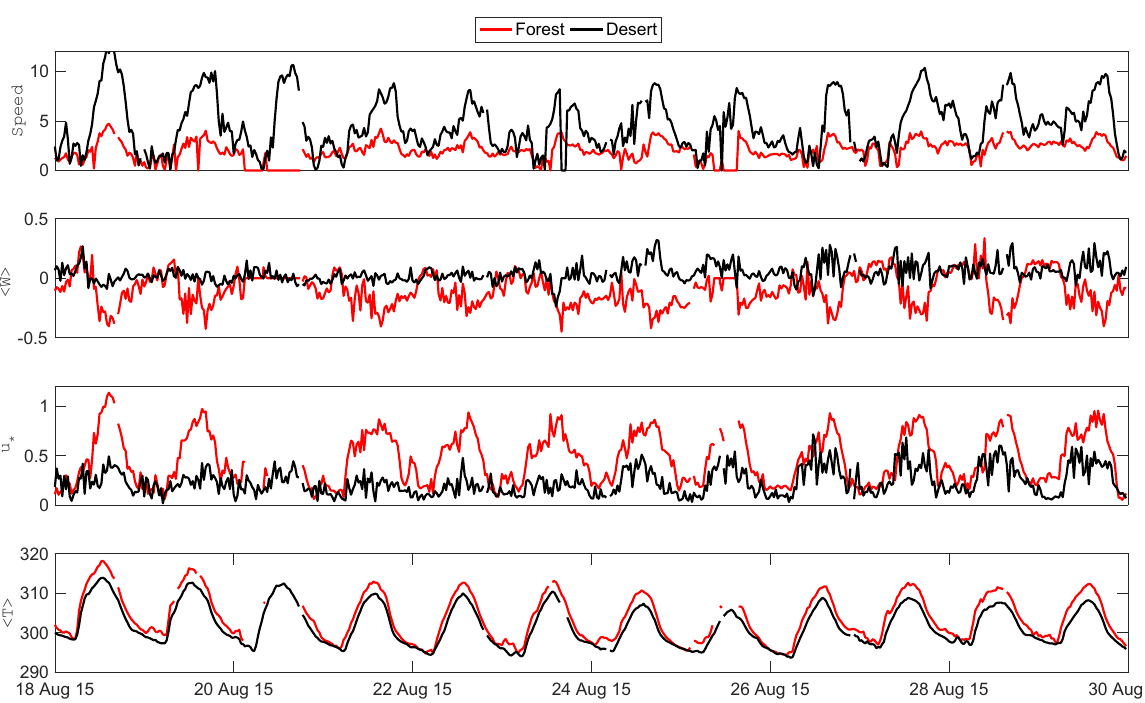
Figure 2. Time series of half-hourly averages of mean speed (ms − 1 ), mean vertical velocity (ms − 1 ), friction velocity (ms − 1 ) and mean potential temperature (K) for the measurement period. The black line indicates desert, and the red line indicates forest.